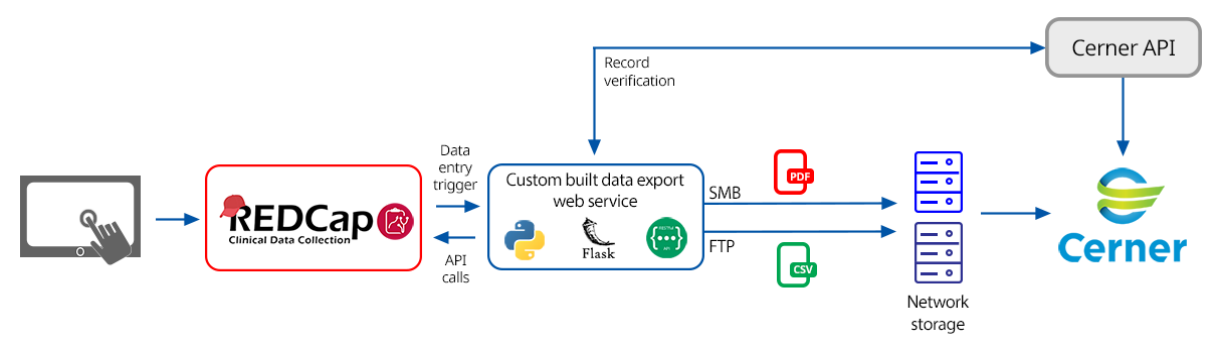
Figure 2. Clinical REDCap workflow and example screens for a typical follow-up appointment for a patient in the major depressive disorder integrated care pathway. API: application programming interface; FTP: file transfer protocol; REDCap: Research Electronic Data Capture; SMB: server message